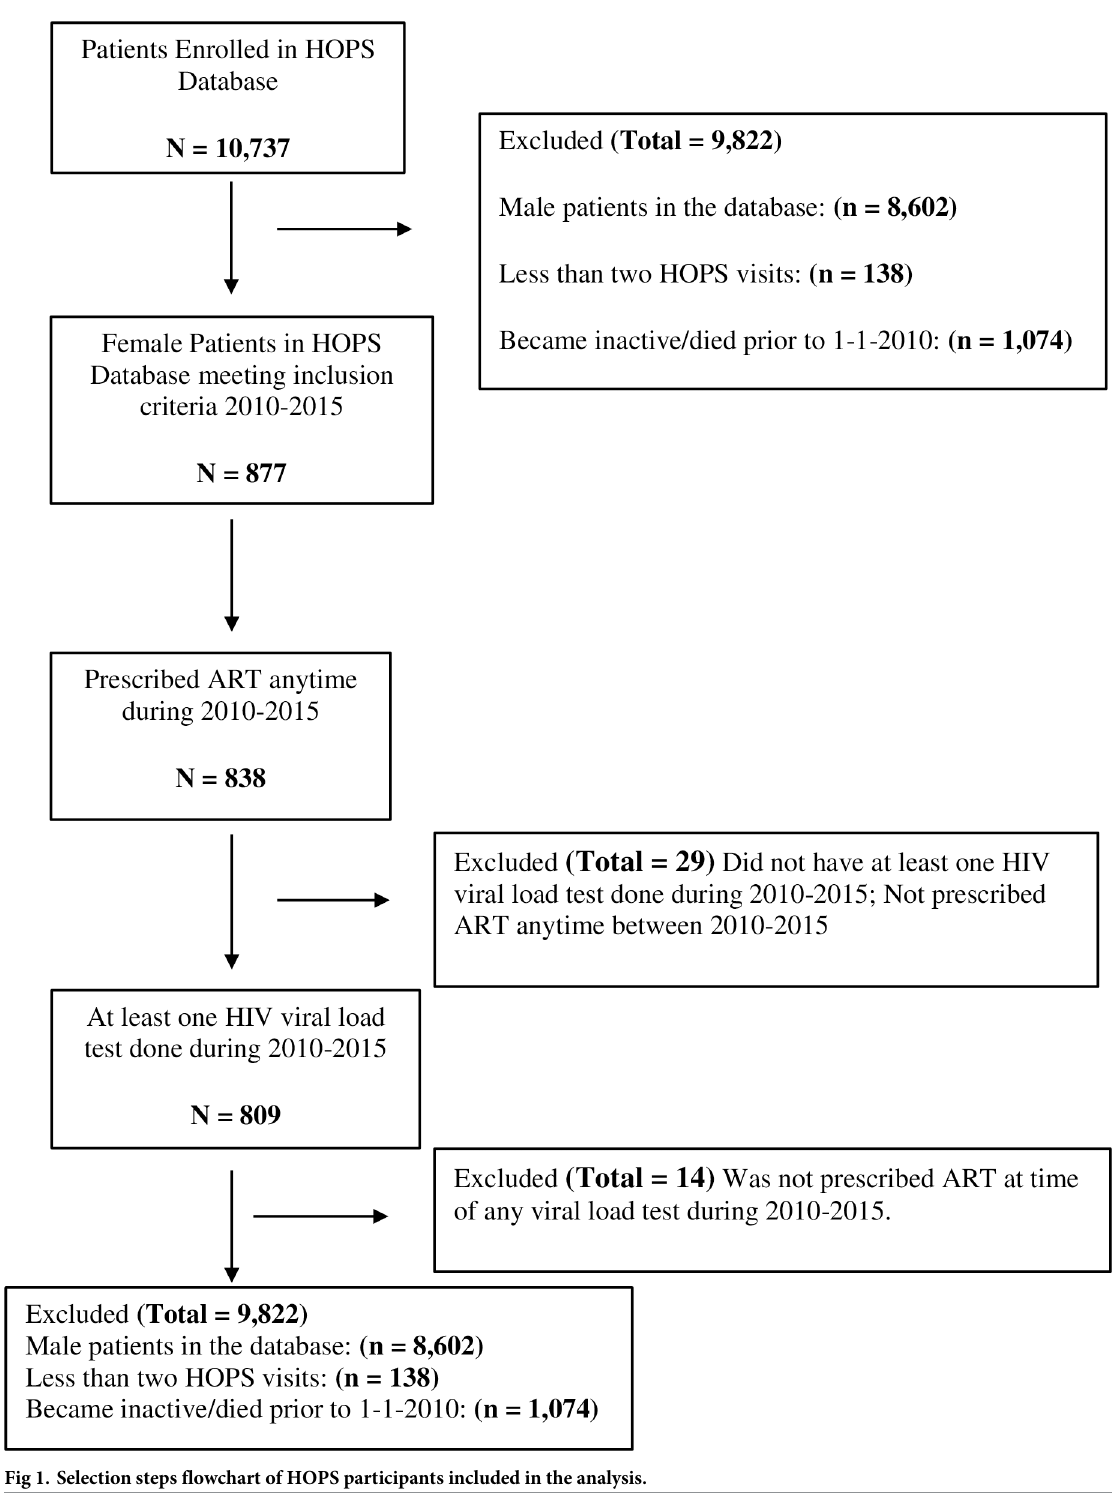
Fig 1. Selection steps flowchart of HOPS participants included in the analysis.